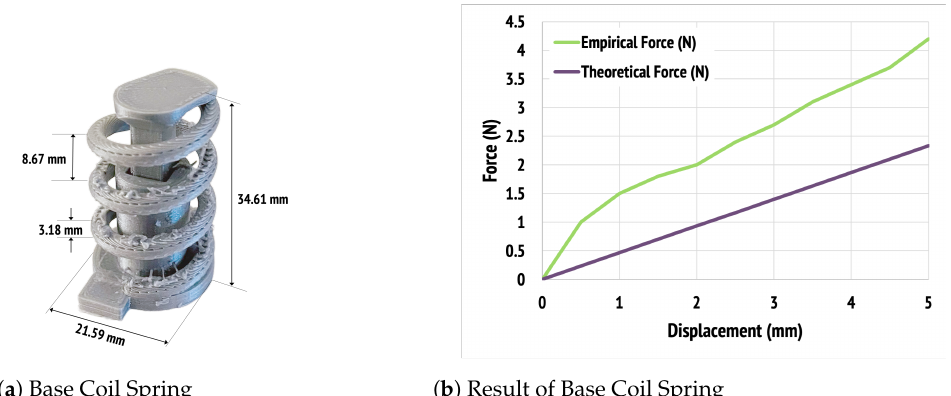
Figure 3. ( a ) 3D-printed base coil spring and its dimensions, and ( b ) the results of force- displacement